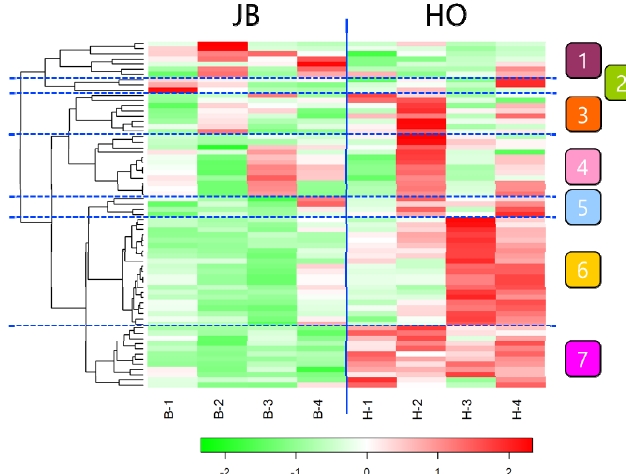
Figure 2. Heatmap of metabolites in Japanese Black Wagyu (JB) and Holstein (HO) sirloin samples. The upregulated metabolites are shown in red, and the downregulated metabolites are presented in green. Cluster 1, which characterized the Wagyu sample, was mainly composed of maltose, xylitol, stearic acid, palmitic acid, and nonanoic acid. Cluster 7, which characterized the Holstein sample, was mainly composed of proline, glycine, succinic acid, amino propanoic acid, creatinine, pyruvic acid, inosine, and ribose. B1-B4: Japanese Black Wagyu ( n = 4); H1-H4: Holstein ( n = 4). Table 1. Main metabolite compounds in Japanese Black Wagyu and Holstein sirloin samples. Relative Area Comparative Analysis Change